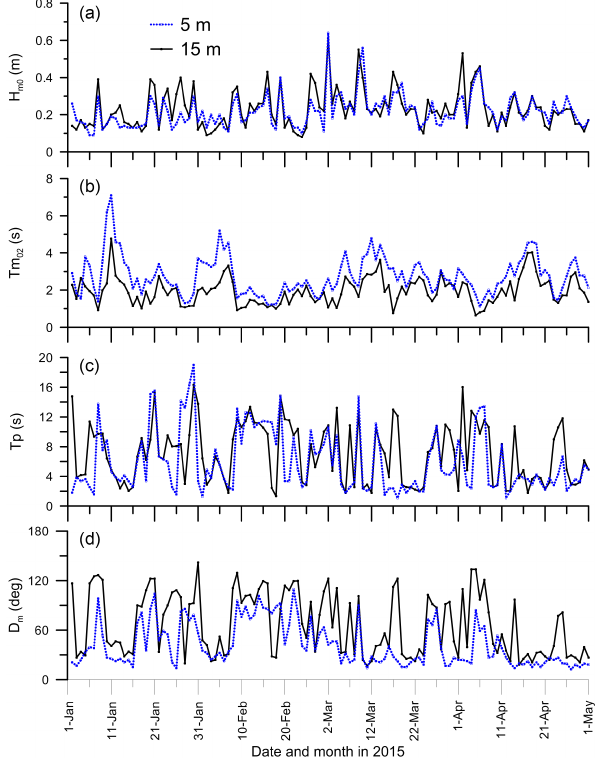
Figure 7. Time series plot showing the range of wave parameters in a day; (a) significant wave height ( H m0 ) , (b) mean wave pe- riod ( T m02 ) , (c) peak wave period ( T p ) and (d) mean wave direction ( D m )